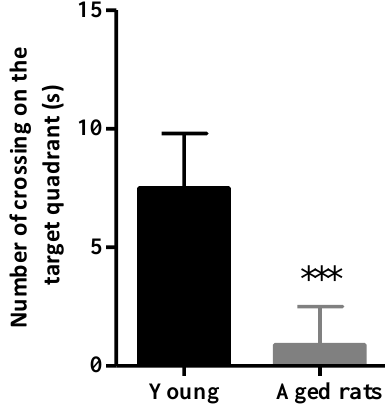
Figure 2. Number of crossings on the target quadrant (mean ± SD mean are represented) *** Significant differences between experimental groups: aged rats ( n = 45) and young ( n = 30) ( p < 0.001). Table 1. Data (mean ± SD mean) from four trials grouped in blocks (B1–B10) for the latency in the MWM and the number of crossings in the target quadrant between experimental